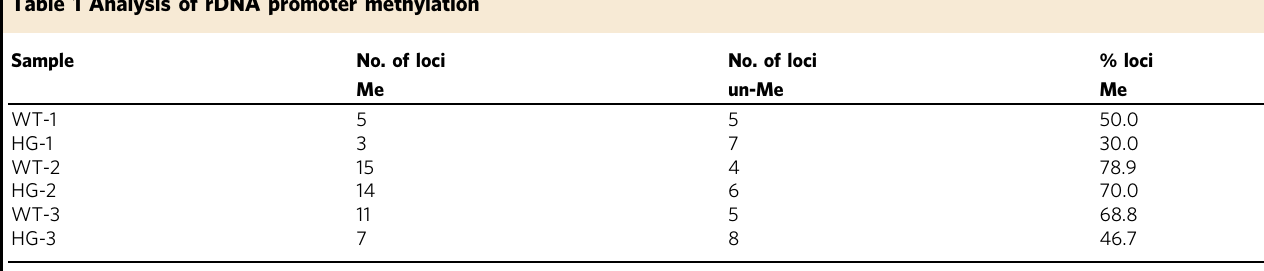
Summary of number of rDNA loci analyzed and percentage of loci with any CpG methylation in WT and HGPS fi